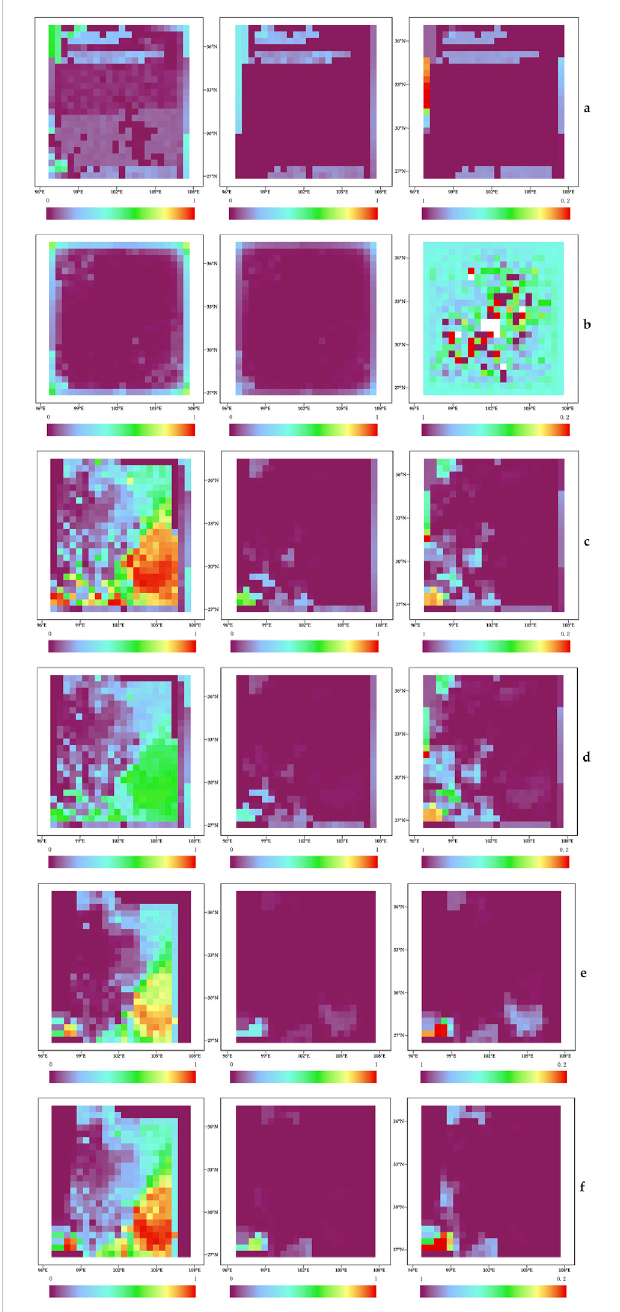
FIGURE 8 TheresultoffrequencyoftheRITandCTIRanomaliesgeneratedby each method in 2010 – 2020 [ (A) : AE, (B) IF, (C) IQR, (D) RST:, (E) WT, (F) Kalman], The x -axis represents the longitude; the y -axis represents the latitude. Subplot-left is the frequency of RIR Signal of the whole area, while Subplot-centeristhefrequencyofCTIR Signal.